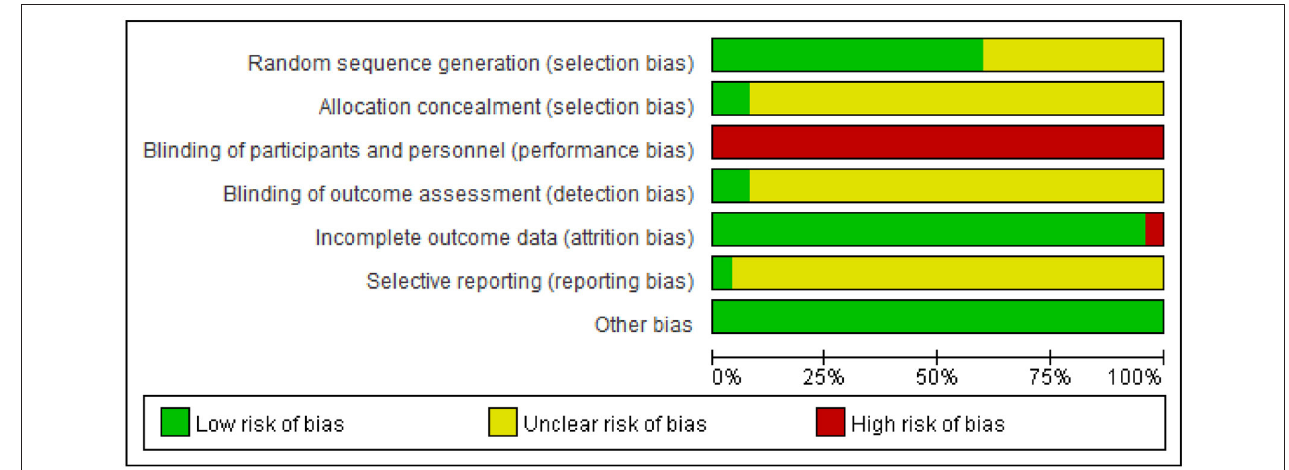
FIGURE 2 | Risk of bias summary. Other biases are assessed based on baseline